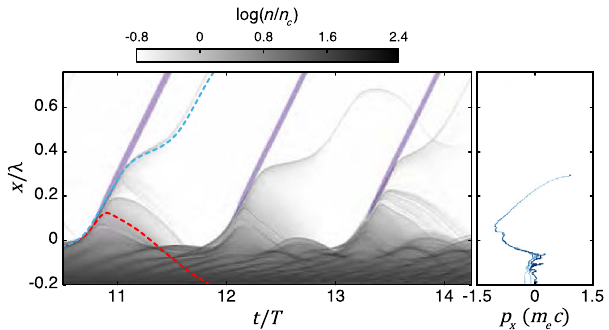
FIG. 1. Temporal dynamics of a dense plasma exposed to an ultraintense laser field in the Brunel regime. This graph displays results from a particle-in-cell simulation performed for a 0 ¼ 2 ( I ¼ 8 . 5 × 10 18 W = cm 2 , λ ¼ 800 nm), θ i ¼ 55 °, and a density gradient scale length L ¼ λ = 10 (with λ the laser wavelength). The gray scale color map shows the temporal evolution, during three laser optical periods, of the plasma electron density around the target surface, while the purple color scale shows the attosecond light pulses emitted by this plasma (harmonics 8 – 15). Two representative trajectories for the particles forming the expelled electron beam (blue) and the “ recolliding ” electron flux (red) are also displayed. The right-hand panel shows a typical distribution of electrons in the x − p x phase space ( x spatial coordinate along the target normal) at time t=T ¼ 12 . 7